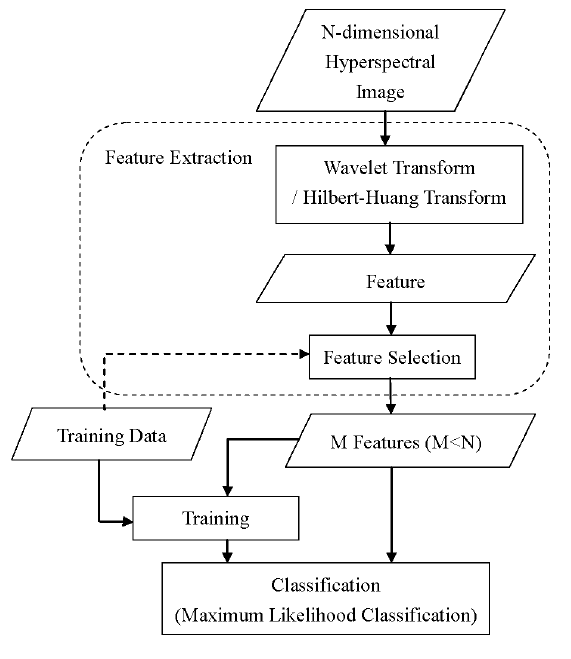
Figure 2. The flow chart of wavelet-based or HHT-based feature extraction